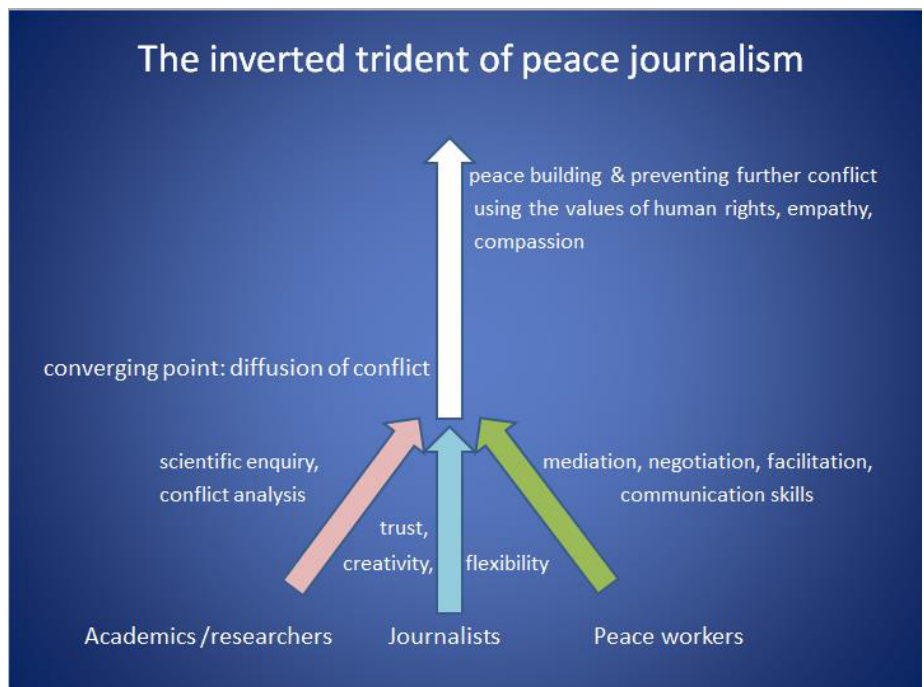
Figure 1. The inverted trident of peace journalism model that shows the values shared between journalists, researchers and peace workers. Meeting together to reduce the conflict they then unify and develop to build peace and prevent fur- ther conflict (Source: Aslam, 2014, p.